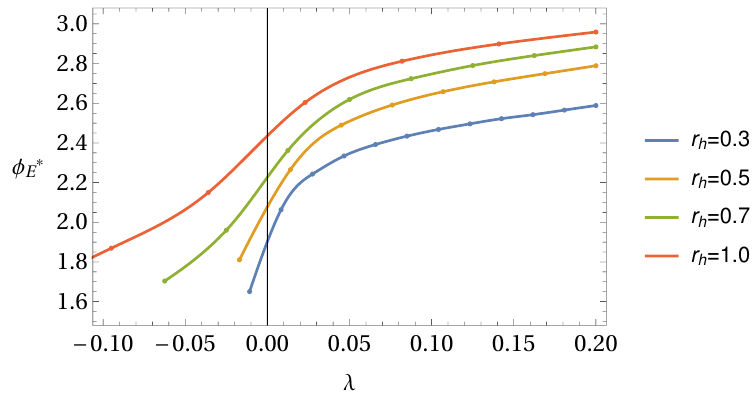
Figure 6. Critical points (cid:30) (cid:3) for several values of horizon radius r h as a function of the Gauss- E Bonnet coupling (cid:21) . The point (cid:30) (cid:3) is de(cid:12)ned as the value of (cid:30) A at the phase transition of entan- E glement entropy where the two candidates to minimal surface, one homologous to A and the other homologous to A c plus the horizon surface, exchange